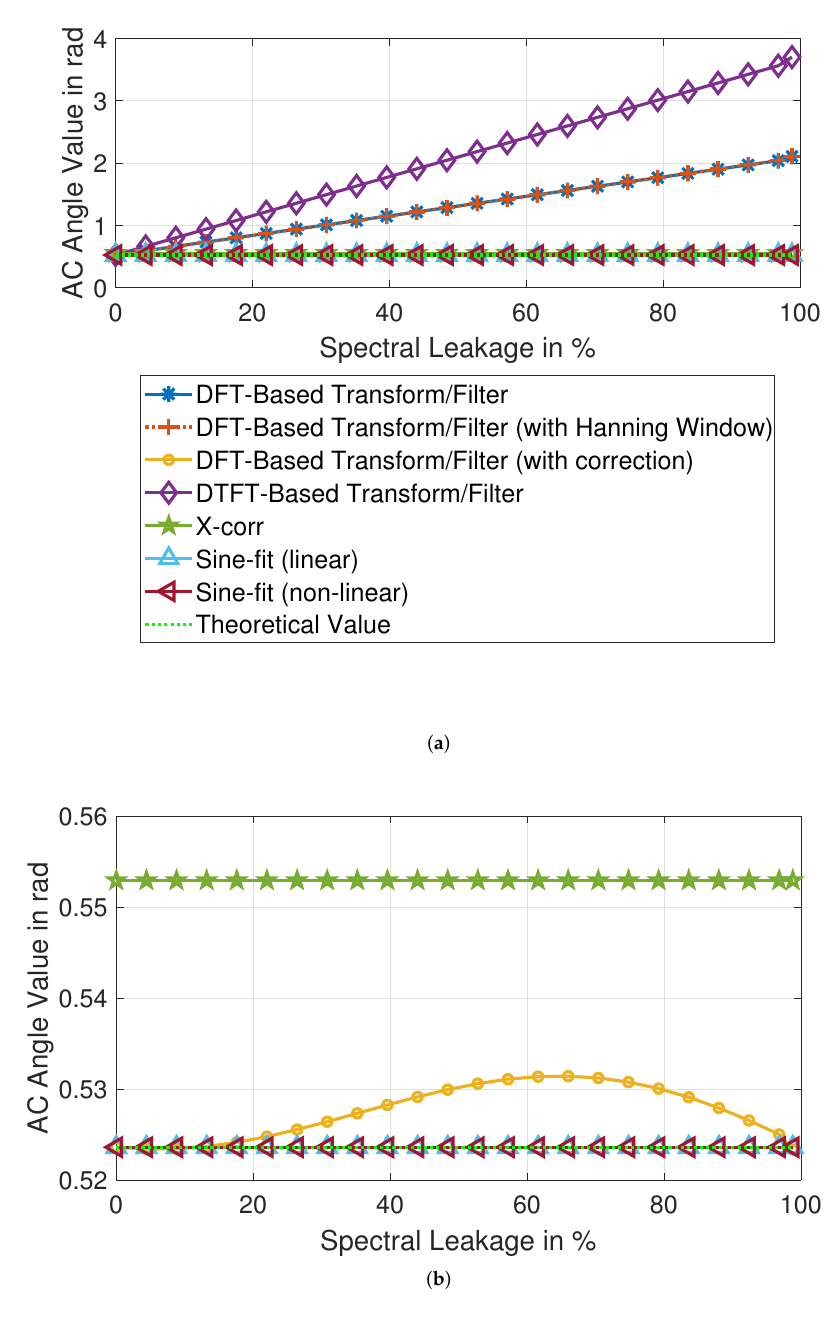
Figure 5. ( a ) Full Comparison of the Different Signals. ( b ) A Zoom into the most Precise